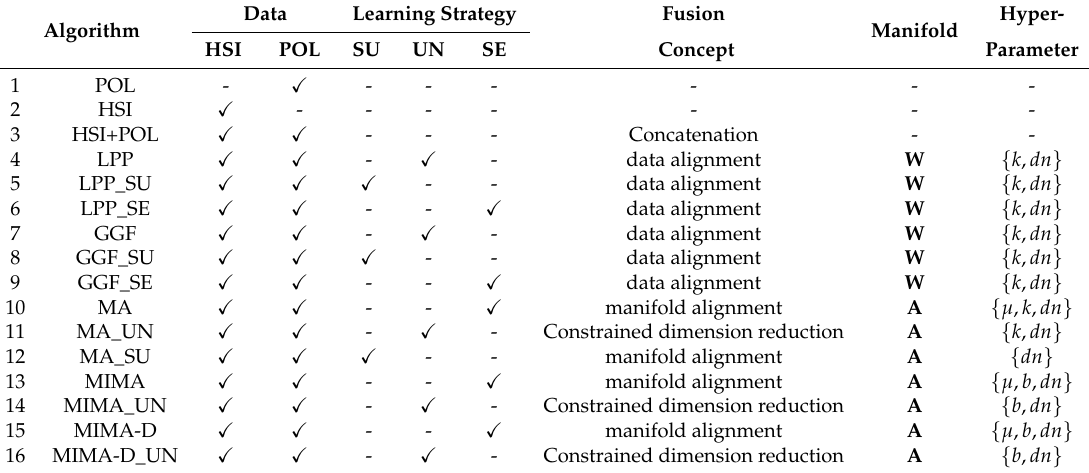
Table 4. Technical summary of the selected algorithms. ’SU’, ’UN’, and ’SE’ represent the learning strategy of supervised, unsupervised, or semi-supervised, respectively. W and A represent the weight matrix and the connection matrix, respectively. The hyperparameter set { k , dn , µ , b } indicates the number of neighbors, the number of dimensions, the topology weighting parameter, and the number of